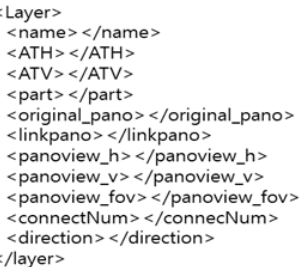
Figure 6. Topology data in XML